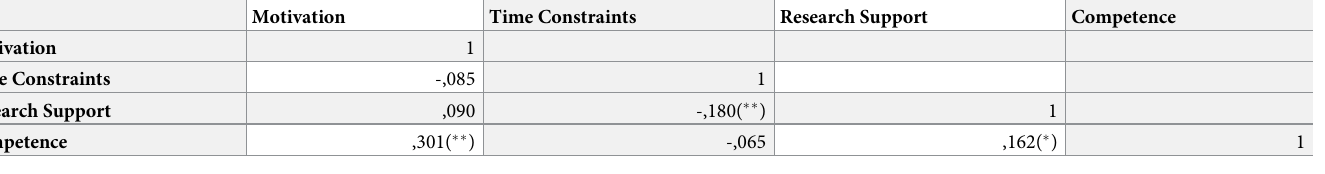
Table 4. Research barriers scale factors correlation